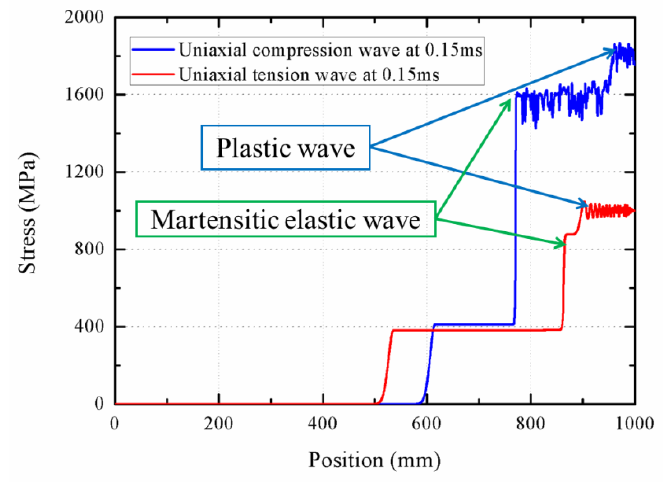
Figure 15. Stress profiles during the wave propagation with various loading directions.